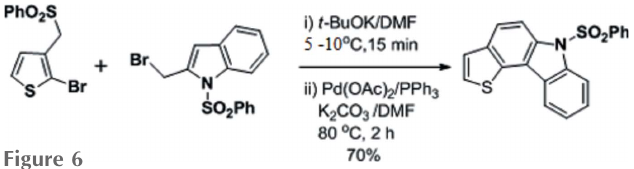
Figure 6 Reaction scheme.